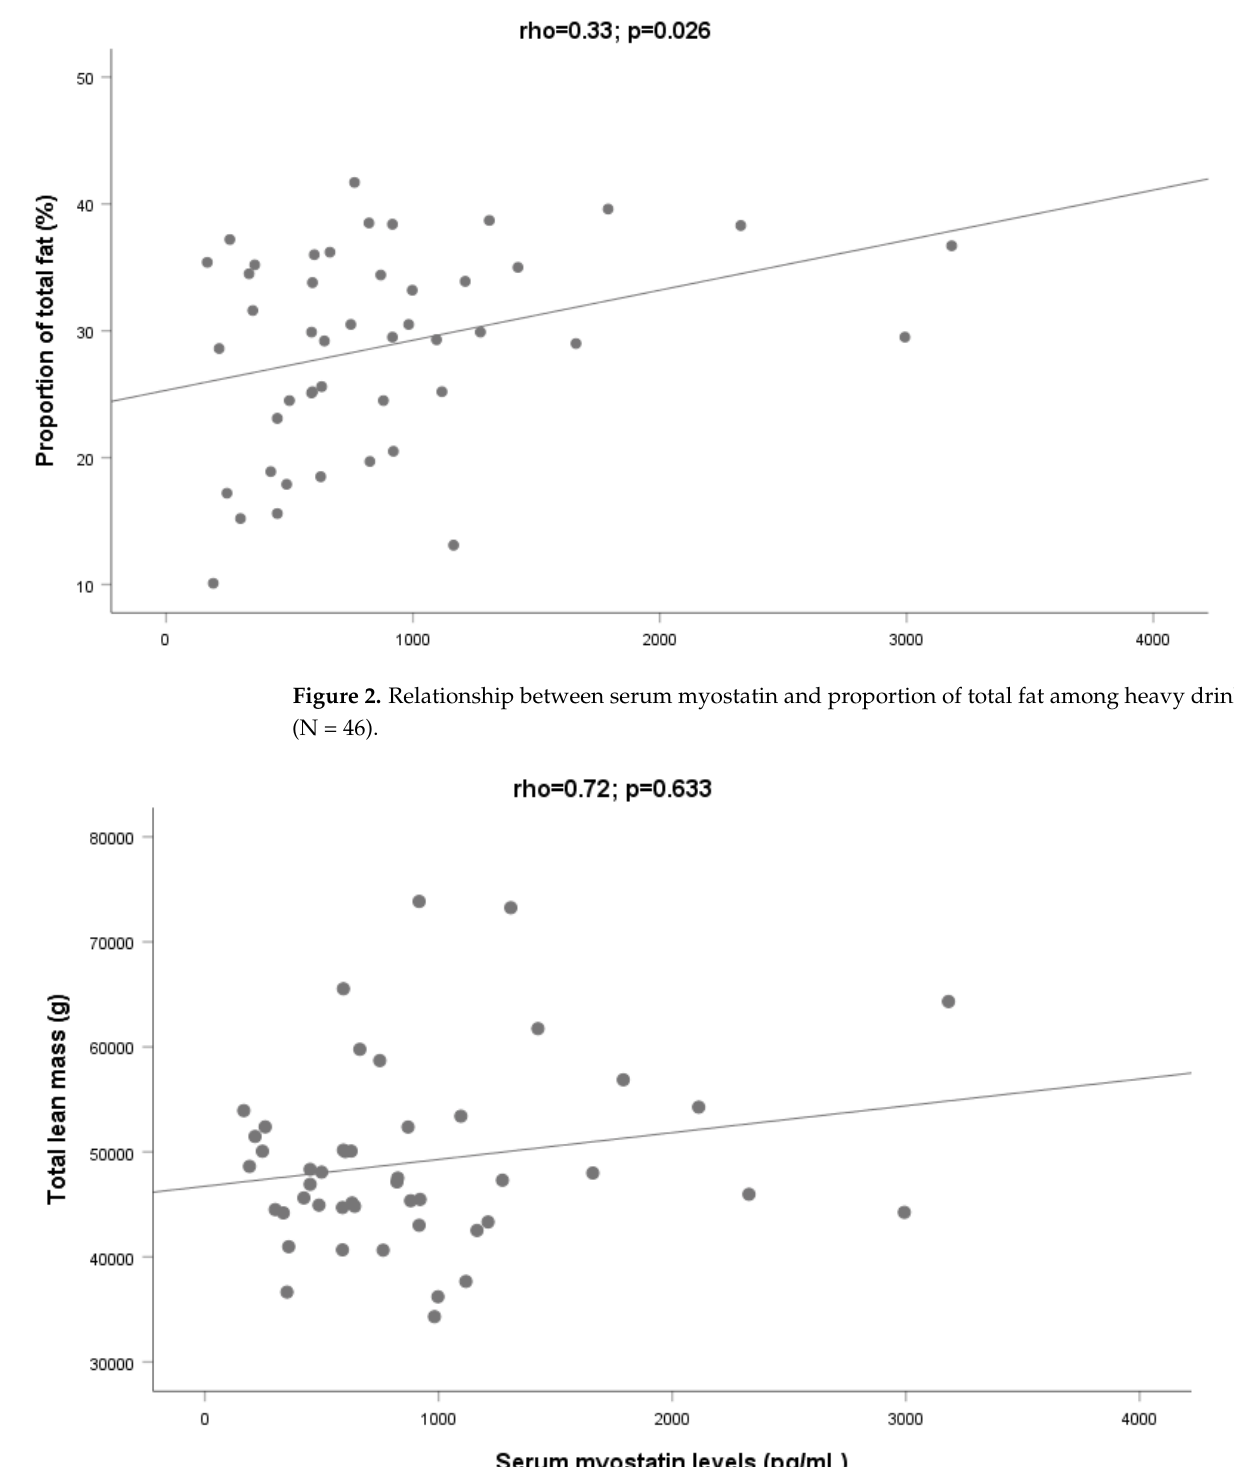
Figure 4. Relationship between serum myostatin and body mass index among patients (N = 47).